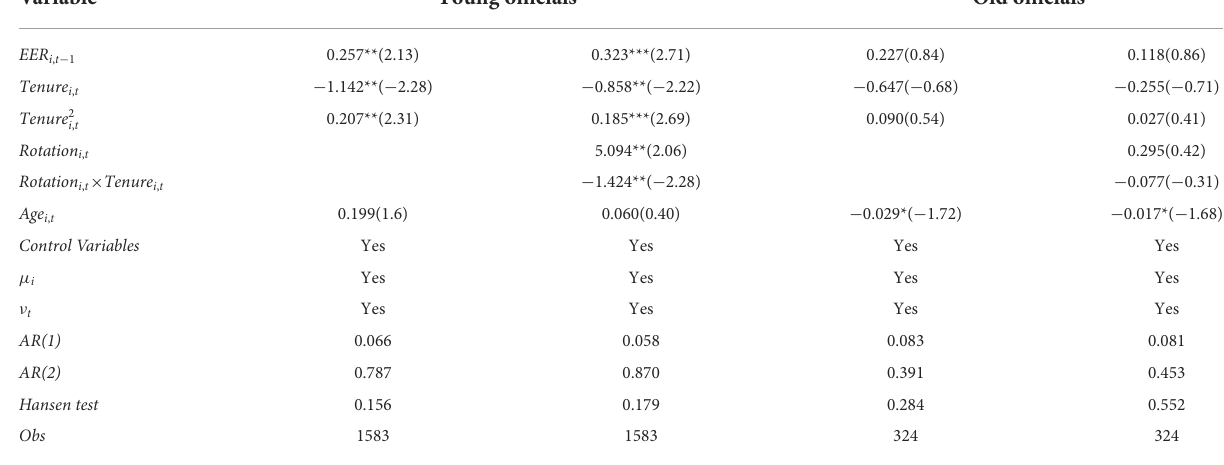
TABLE 6 Empirical results of official age heterogeneity.